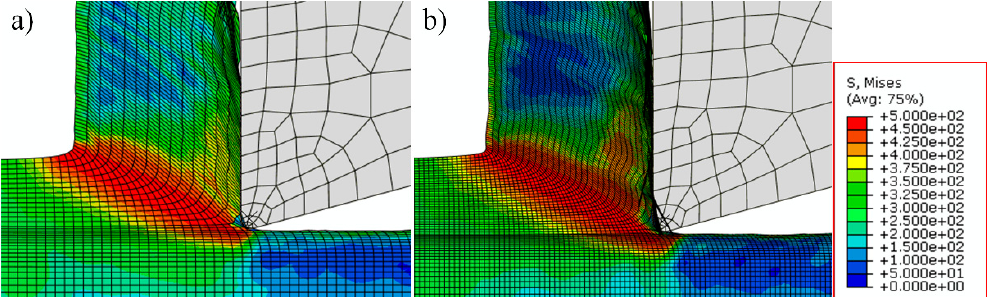
Figure 2. Testing results of mesh sensitivity, ( a ) current mesh and ( b ) finer mesh.